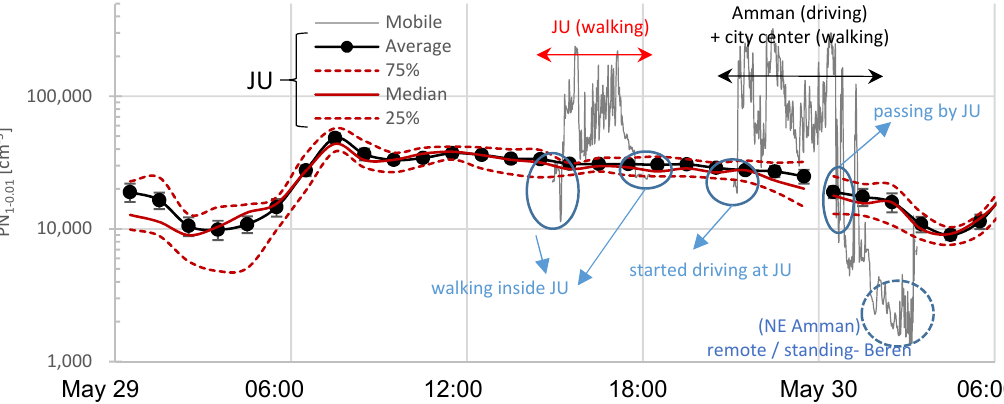
Figure 3. Submicron particle number concentrations (PN 1–0.01 ) measured during mobile campaigns on May 29th and continued on May 30th. The results are plotted along with the diurnal pattern observed at the reference urban background (campus of the University of Jordan).